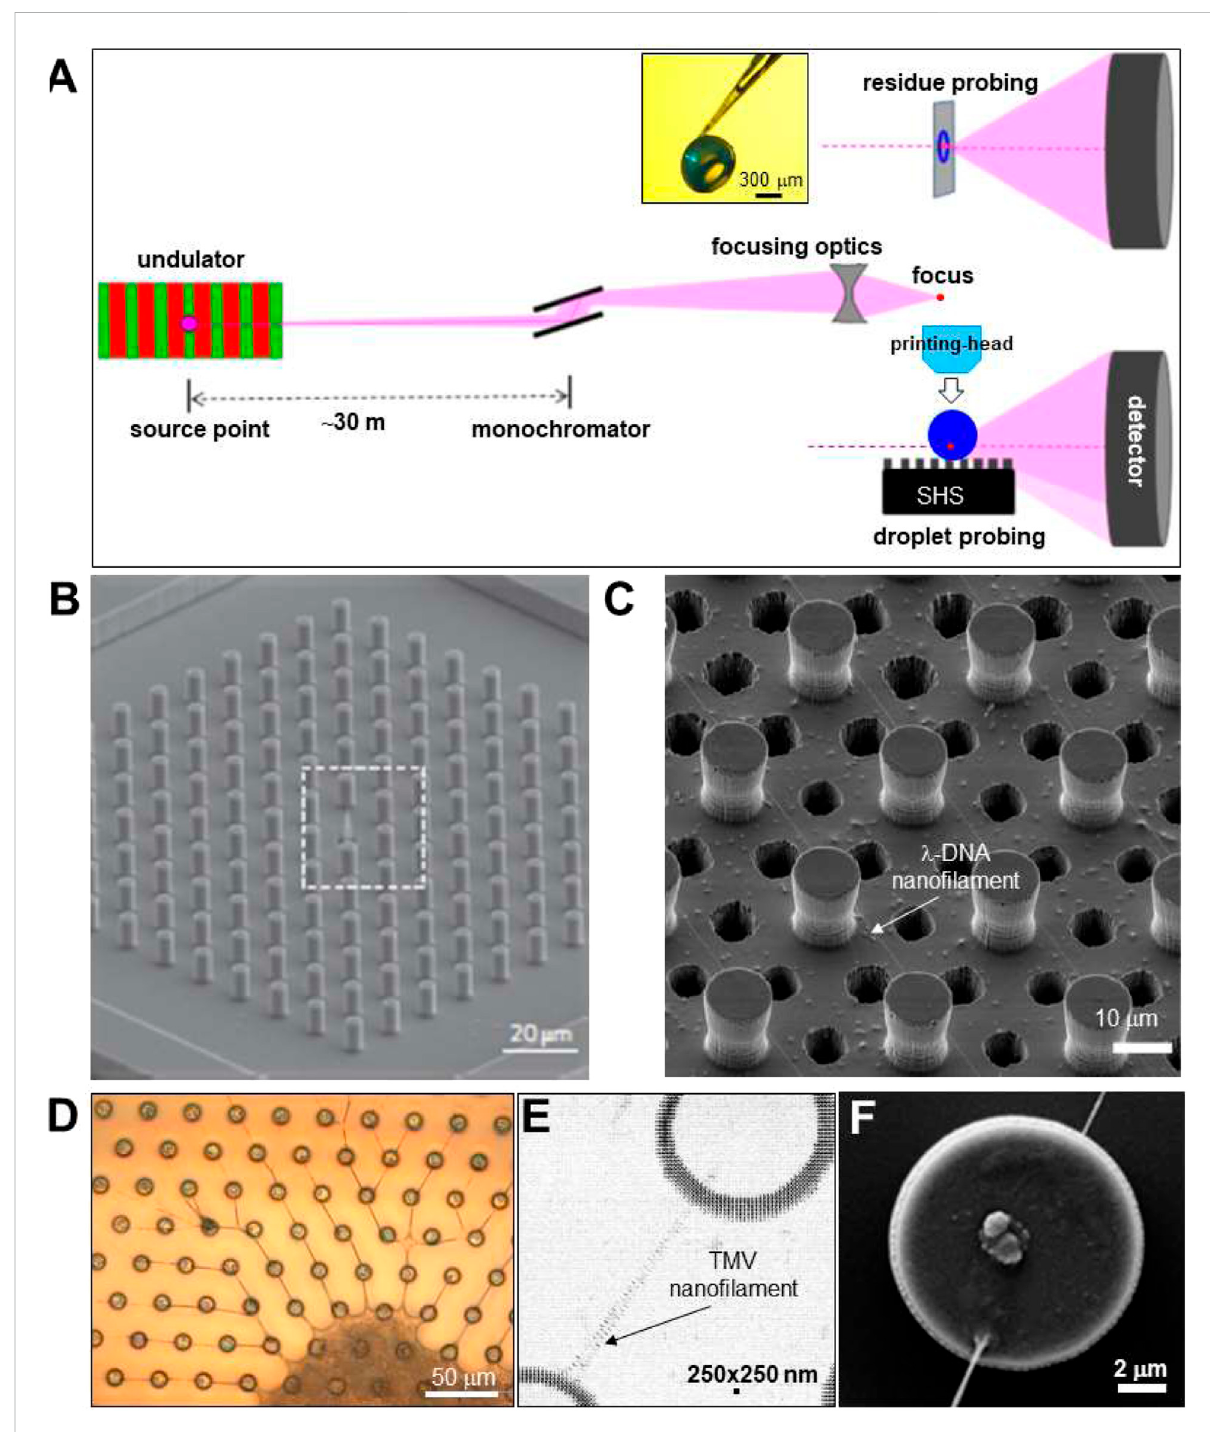
FIGURE 2 (A) SchematicdesignoffocusingSRbeamline.ThepinkundulatorbeamismonochromatizedbyaSicrystalandfocusedtothesampleposition. Twotransmissionscatteringgeometriesareshownfor(i)probingadropletwiththebeamparalleltotheSHSsubstrateand(ii)asamplewiththebeam normal to the substrate. Adapted from: (Marinaro et al., 2016). The inset shows a hollow, spherical lysozyme residue attached to a glass capillary tip (Accardoetal.,2011b). (B) SEMimageofregularpatternofpillarswithacentralcone,etchedintoSiwafer.Adaptedfrom:(DeAngelisetal.,2011). (C) SEM image of pillared Si-SHS and 6 μ m etched holes for imaging λ -DNA nano fi laments by TEM. Adapted from: (Gentile et al., 2012). (D) Optical microscopy image of TMV nano fi laments and central residue attached to SU-8 pillars on a Si 3 N 4 membrane. (E) Density map obtained by mesh- scanning TMV nano fi lament composed of two sub- fi laments, spanning two SU-8 pillars. The contrast is provided by form factor scattering from the nano fi laments and interface refraction from the edge of the pillars. (F) SEM image of Si-pillar with attached nano fi laments. E/F: Adapted from: (Marinaro et al.,